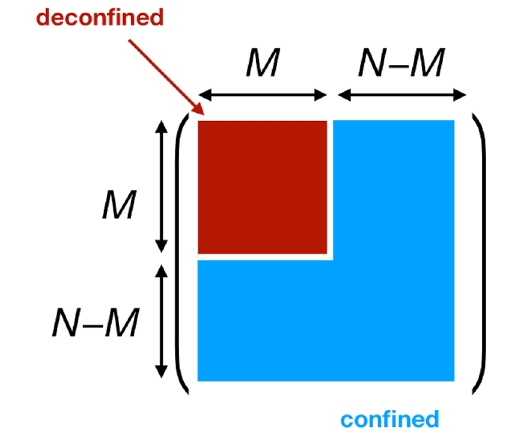
Figure 1. Pictorial representation of partial deconfinement for gauge and adjoint matter degrees of freedom. Only the M × M -block shown in red is excited. This picture is taken from ref. [4]. In this figure, one specific embedding of SU( M ) into SU( N ) is